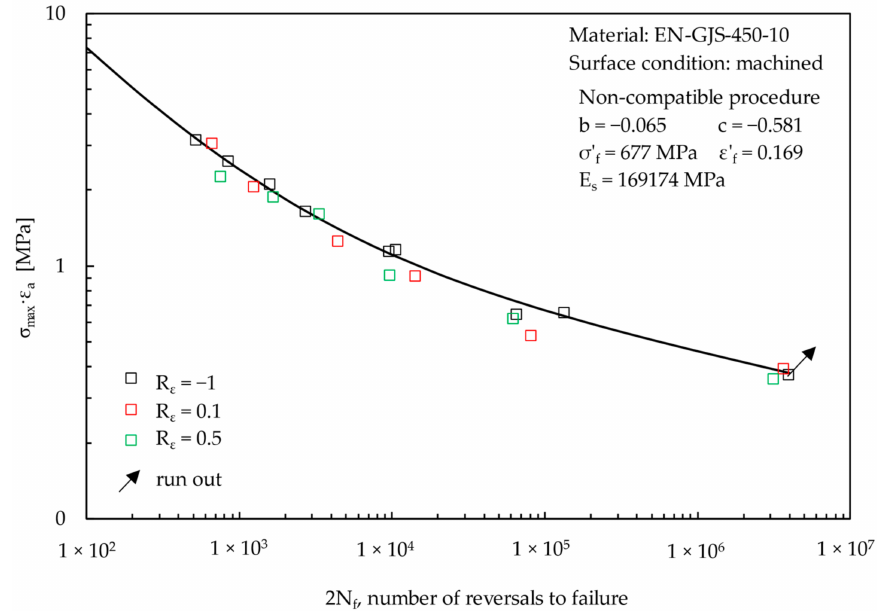
Figure 18. Strain-controlled fatigue test results generated from EN-GJS-450-10 specimens tested under R ε = − 1 (Figure 10a), 0.1 (Figure 10c), and 0.5 (Figure 10d) in the machined conditions and expressed in terms of the parameter σ max · ε a , according to Smith–Watson–Topper [50]. The figure includes the curve σ max · ε a versus 2N f (Equation (9)), the material parameters being those fitted only on experimental results relevant to R ε = − 1, as reported inside the